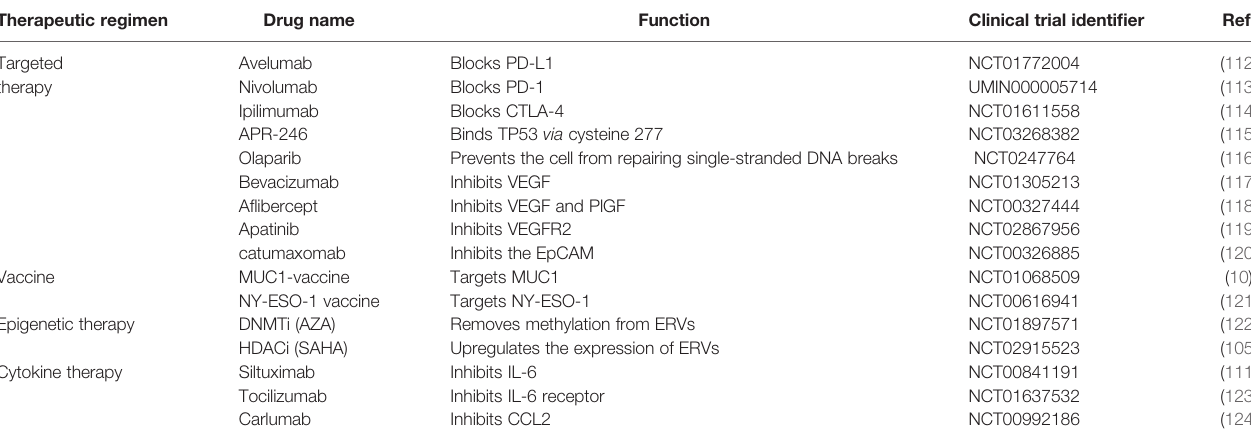
TABLE 4 | Major selected drugs and therapy regimens in clinical studies for ovarian Cancer. Therapeutic